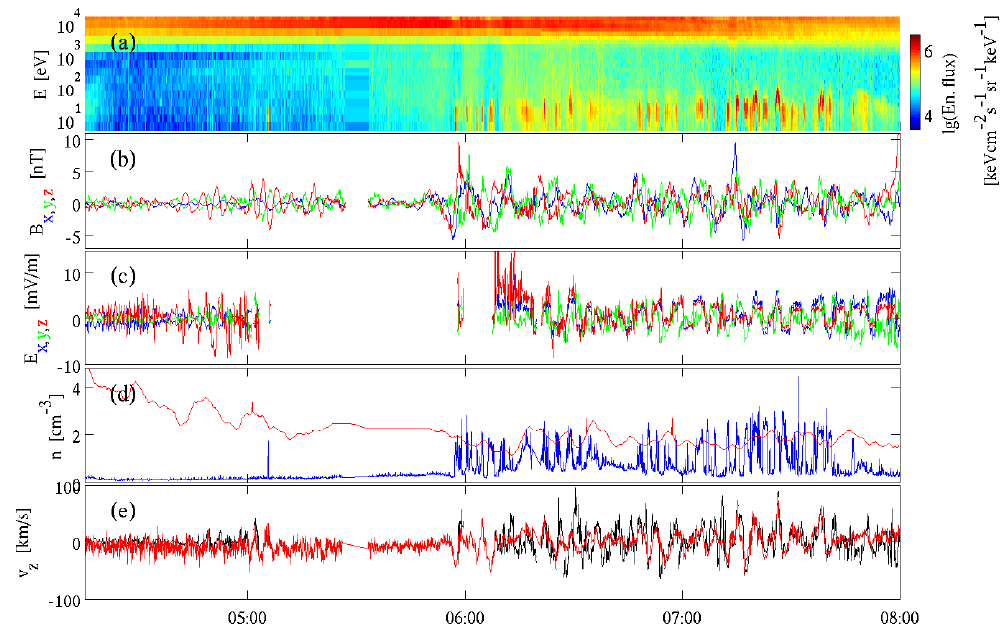
Figure 11. Data from Cluster 1 between 04:15 and 08:00 on 15 March 2007. (a) Omnidirectional ion energy flux. (b) Magnetic field in the frequency range 1 . 4 mHz ≤ f ≤ 0 . 25 Hz. (c) Electric field for f ≤ 0 . 25 Hz. (d) Density measured by CIS-HIA (blue curve) and Whisper (red curve). (e) The GSE z component of the ion velocity measured by CIS-HIA (red curve) and the z component of E × B / | B | 2 computed from EFW and FGM data (black